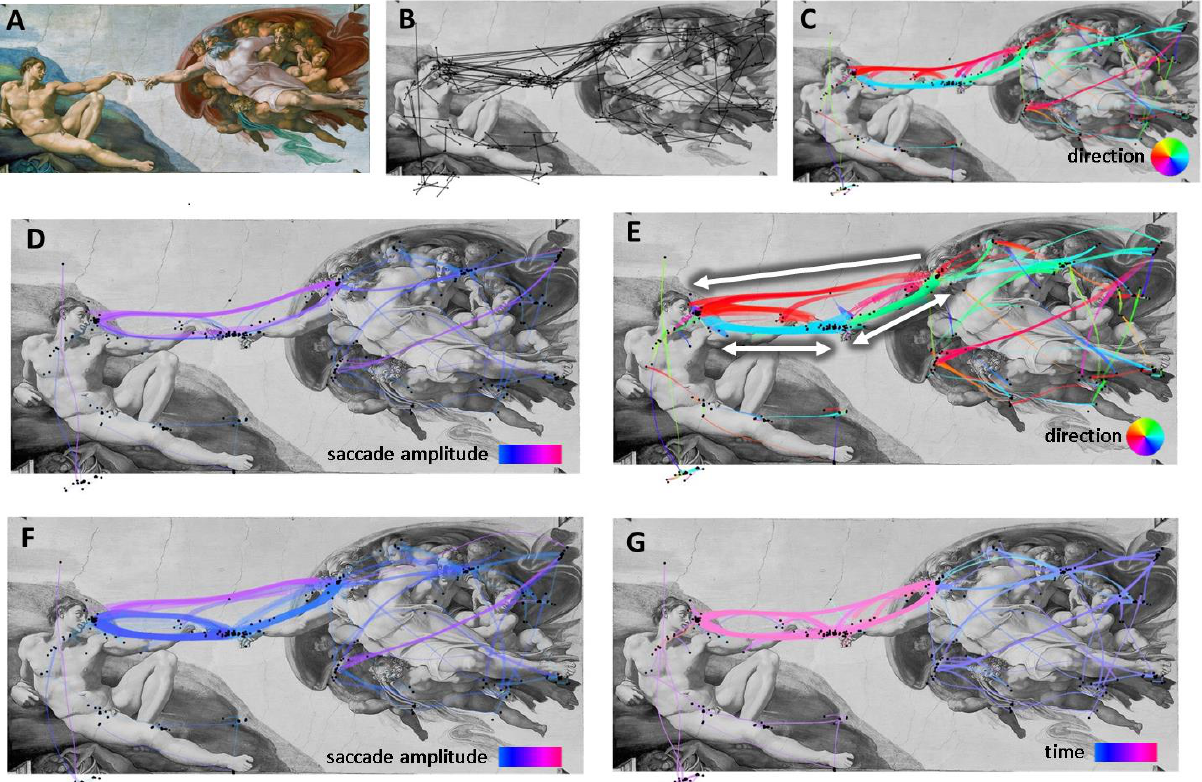
Figure 8. The scanpath visualization of the dataset for the Michelangelo painting. A) visual stimulus, B) raw fixations and saccades, C) data bundled according to saccade direction, D) layout “C” colored according to sac- cade length, E) data bundled according to both direction and saccade length, F) layout “E” colored according to saccade length, G) layout “C” colored according to